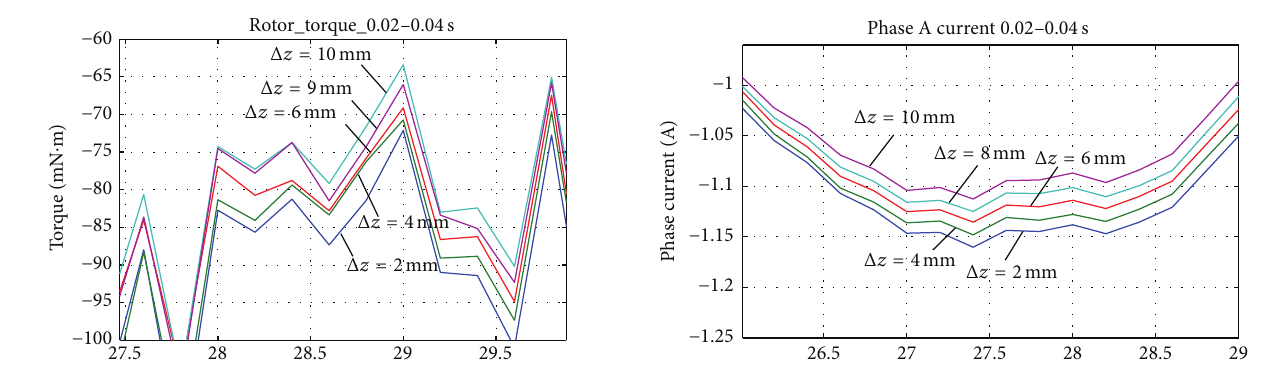
peaksPhase A current 0.02 – 0.04 s valleysZoom in